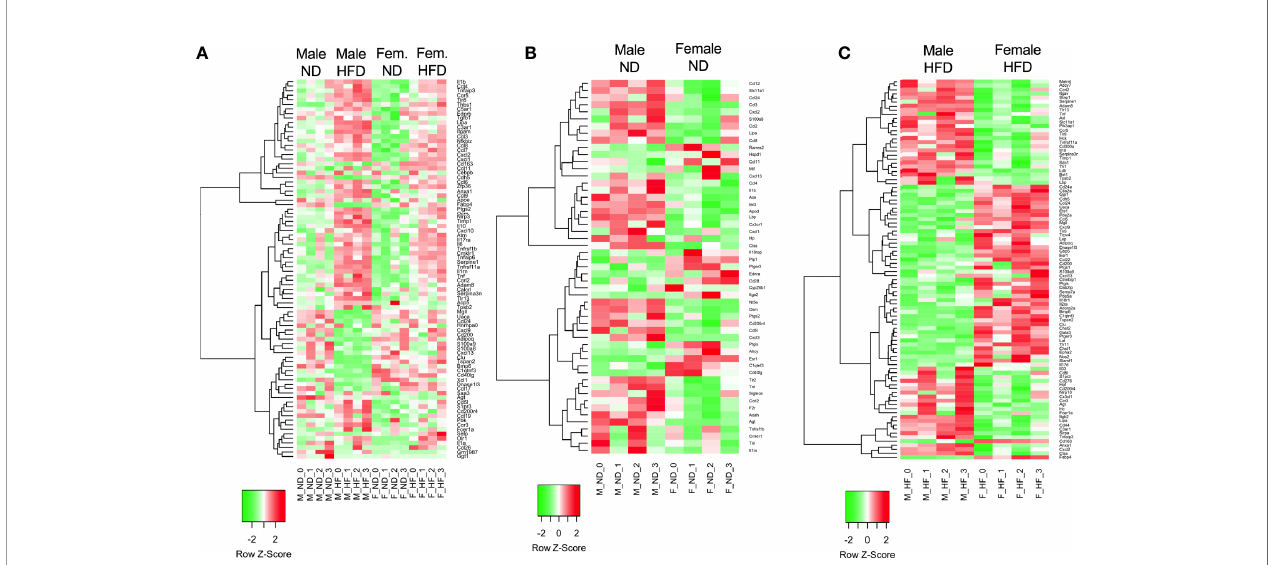
FIGURE 2 | RNA signatures differ in the GO term of in fl ammatory responses. RNA-seq from male and female ND and HFD ATMs that had signi fi cant differences between males and females [log2(fold change)] in the GO term in fl ammatory responses were plotted in heatmaps. (A) All groups, (B) ND animals, and (C) HFD animals. N = 4 per